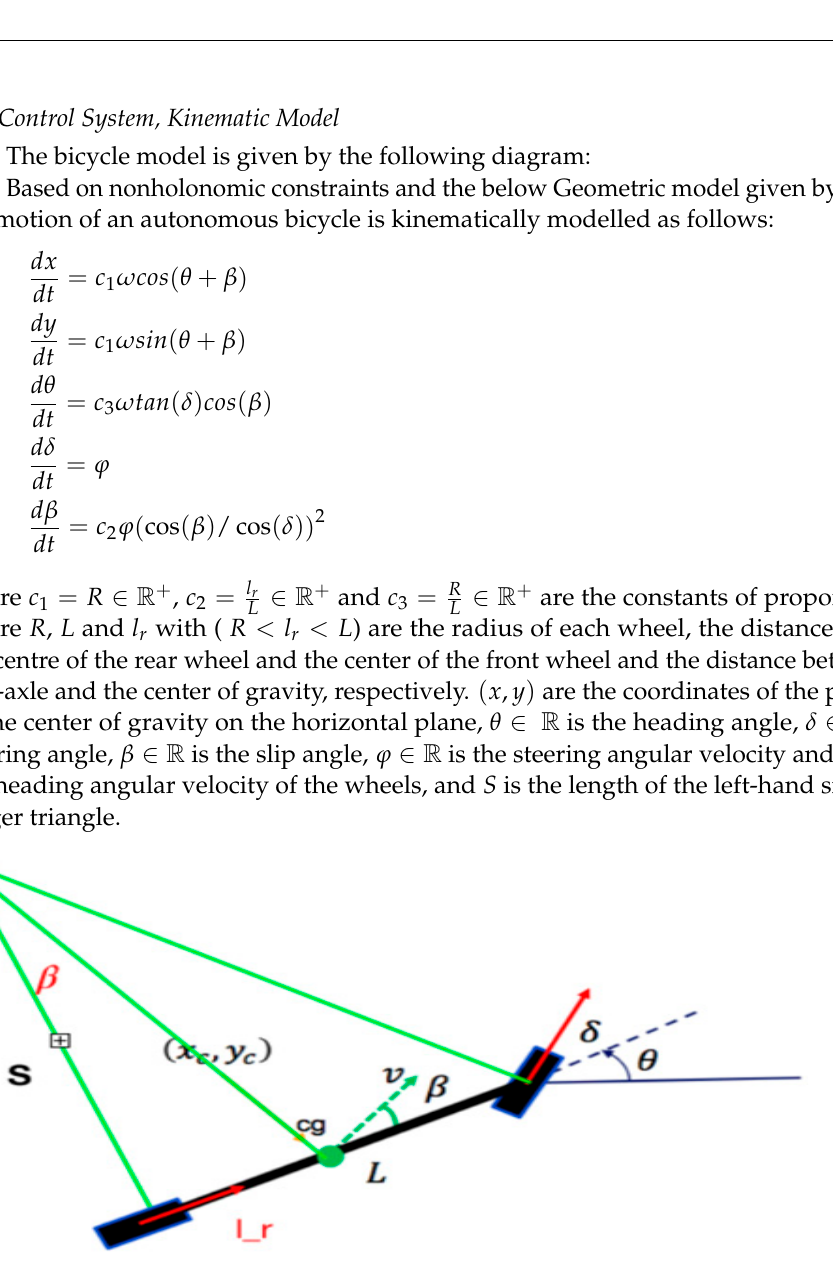
Figure 1. Geometric Model of a Center of Gravity-based autonomous Bicycle Robot.